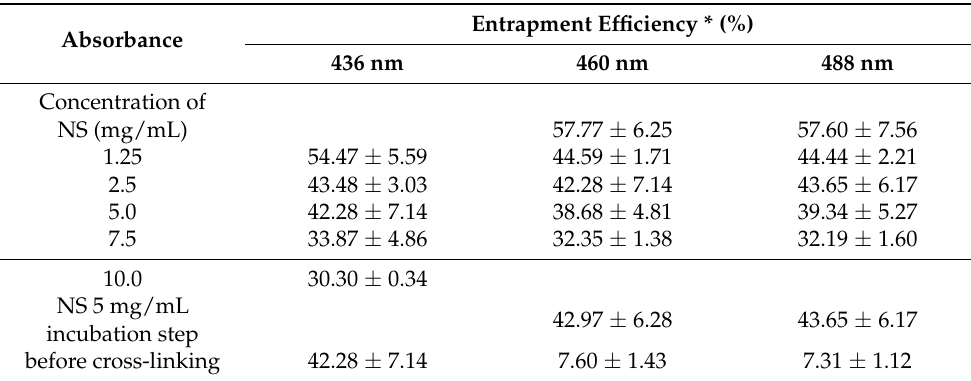
Table 1. Percentage of entrapment efficiency of non-sericin incorporation into HSA